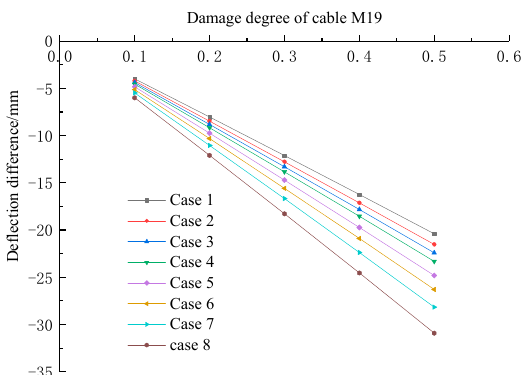
Figure 11. The distribution curve of the deflection difference of the girder before and after M19 damaged when the stiffness of the girder changed.